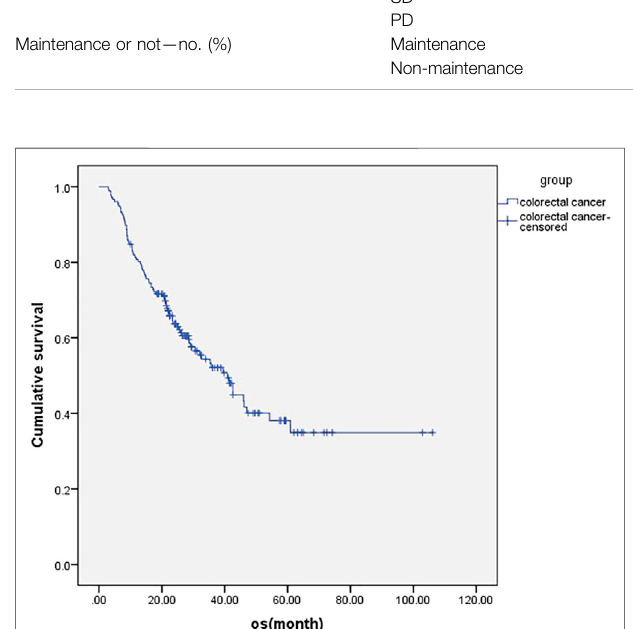
Frontiers in Pharmacology |